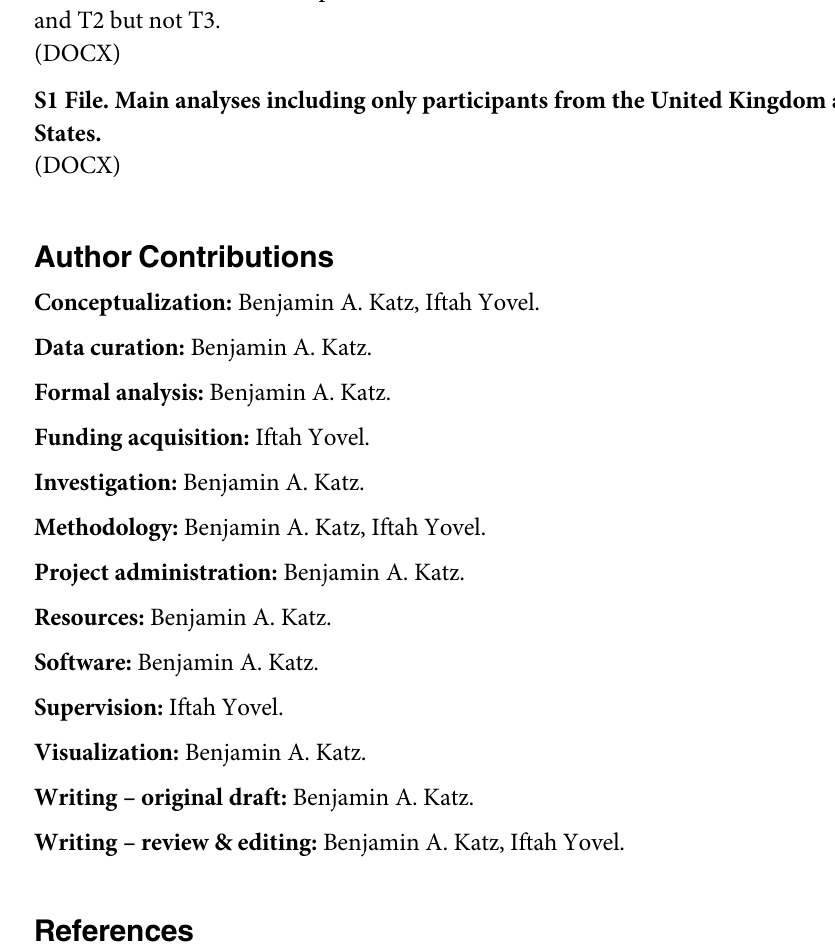
S1 Table. Additional demographic information of sample. S2 Table. Comparison of participants that did and did not return for later assessments. T1 returners are those who returned for T2. T1 dropouts are those who did not return for T2. T2 returners are those who completed T1, T2, and T3. T2 returners are those who completed T1 and T2 but not T3. S1 File. Main analyses including only participants from the United Kingdom and United